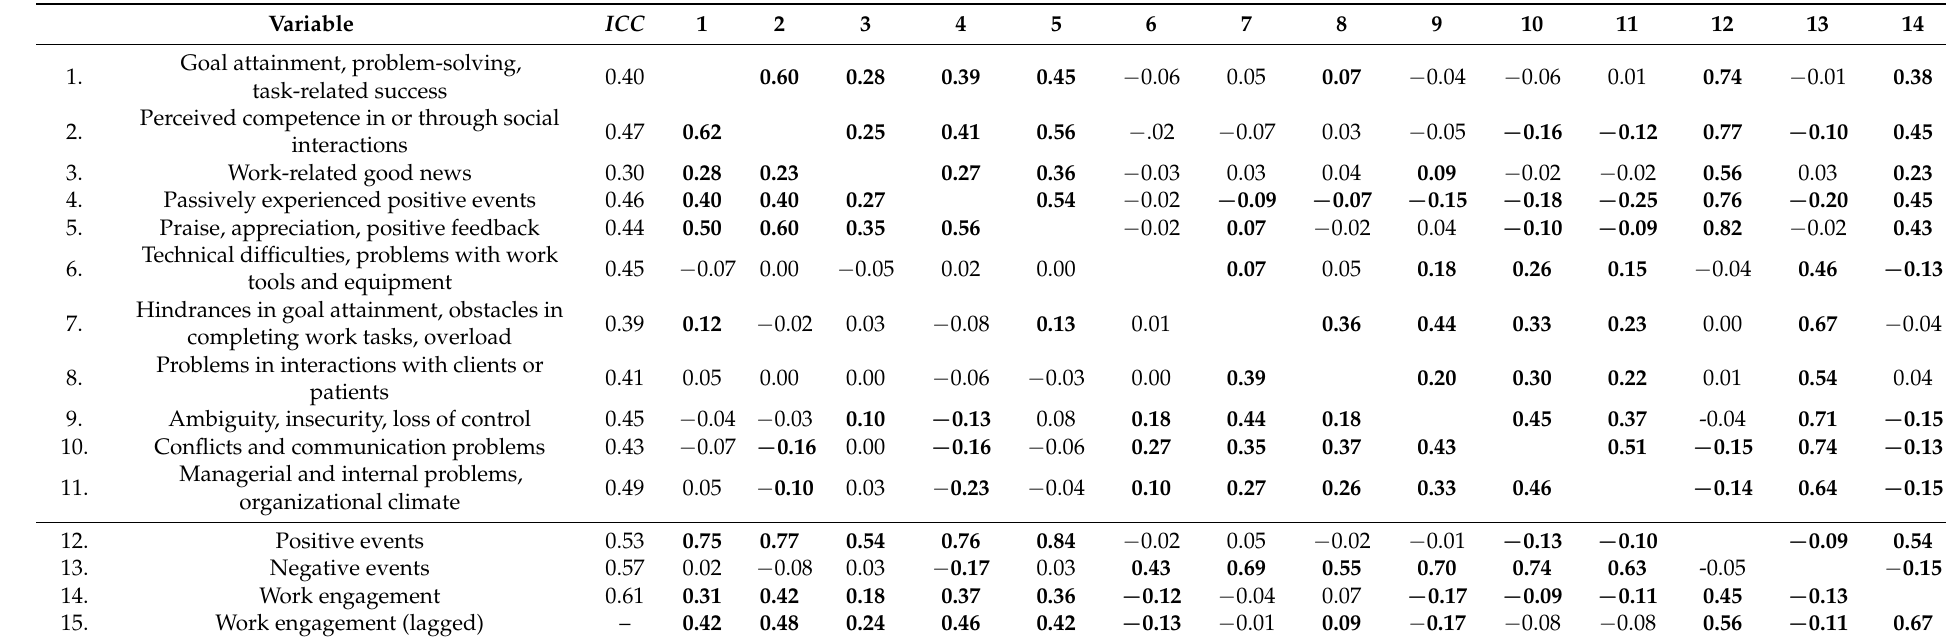
Table 1. Correlations Among Study Variables at the Intraindividual